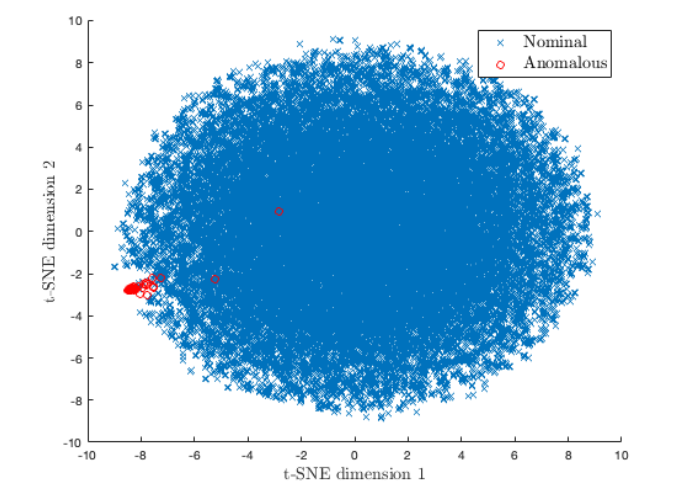
Figure 4. t-SNE plot [37] of the 50-dimensional nominal and anomalous data with change in the mean. NEWMA [38] is an online and multivariate CPD algorithm, that is based on the Exponential Weighted Moving Average algorithm (EWMA). EWMA recursively